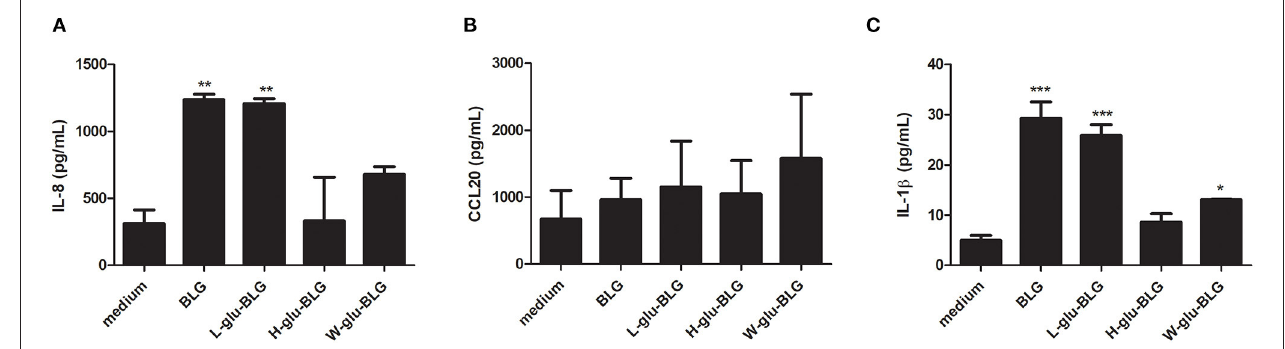
FIGURE 9 | Cytokine response of THP-1 derived dendritic-like cells (iDC) upon exposure to native or heat-treated BLG varies. BLG was untreated or heated (W, H, or L) in the presence of glucose and incubated with iDC. The cytokine secretion of IL-8 (A) , CCL20 (B) , and IL-1 β (C) in the supernatant was analyzed with ELISA. The results represent mean values ± SD of 3 independent experimental measurements. The statistical differences were calculated with Dunnett’s Test compared to medium control: * p < 0.05; ** p < 0.01; *** p < 0.001.